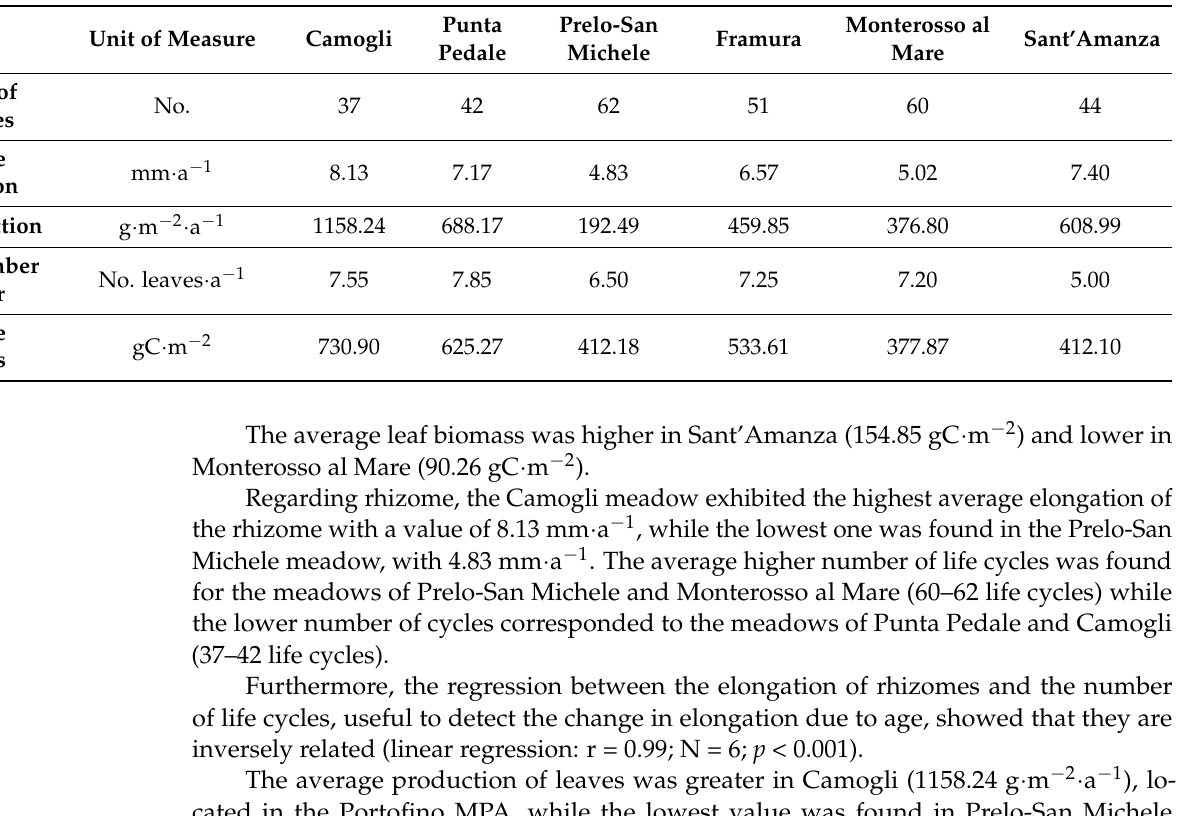
Table 3. Results for the rhizomes of Posidonia oceanica meadows obtained through laboratory analysis. Values are expressed as the average between the two stations of each